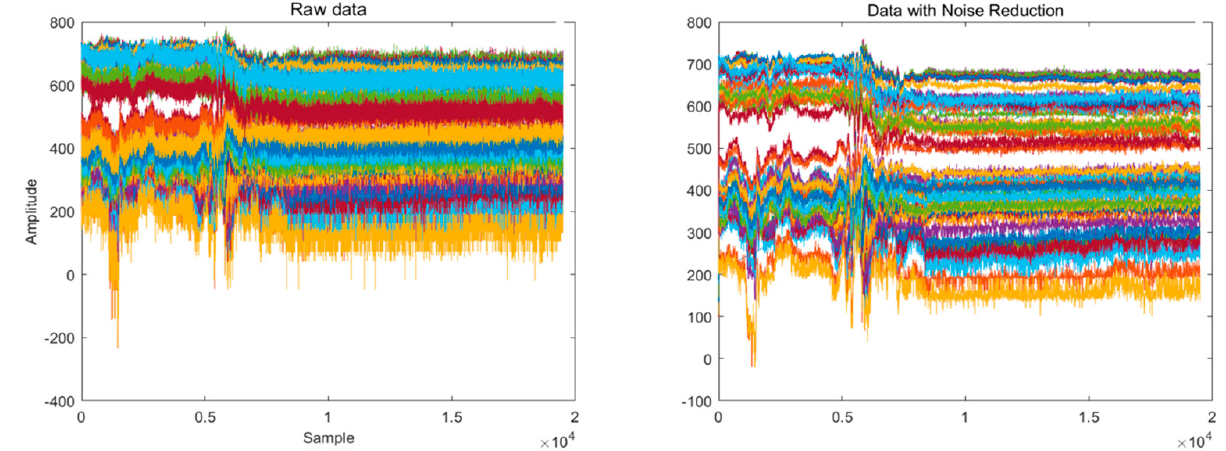
Figure 4. The amplitude of CSI data before and after noise reduction (Each set of CSI data contains 56 subcarriers. Each subcarrier is represented by a color).